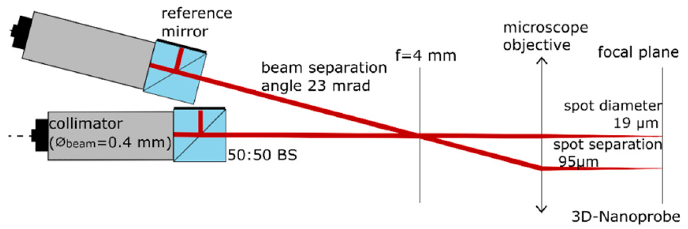
Figure 8. Sketch of the interferometer unit with two interferometer heads (C01, the SmarAct Picoscale company, Oldenburg, Germany). The measured displacements are subtracted in real time, making this unit a differential interferometer.